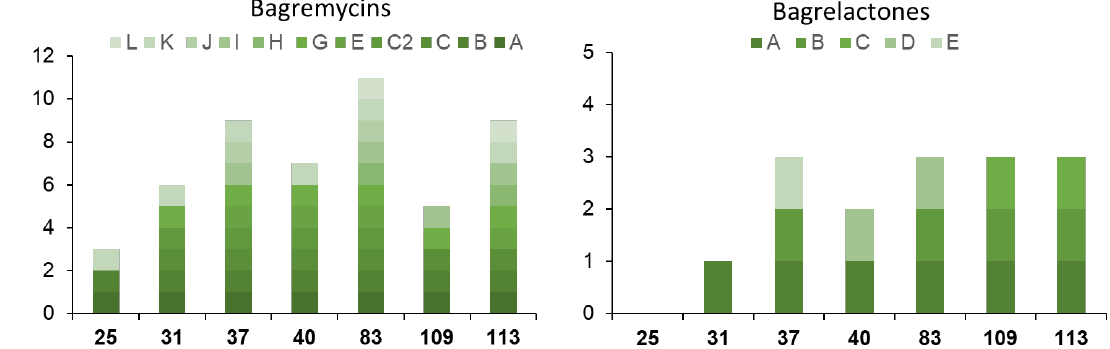
Figure 7. Bagremycins and bagrelactones produced by the seven S. lunaelactis strains selected for our Molecular Networking study.